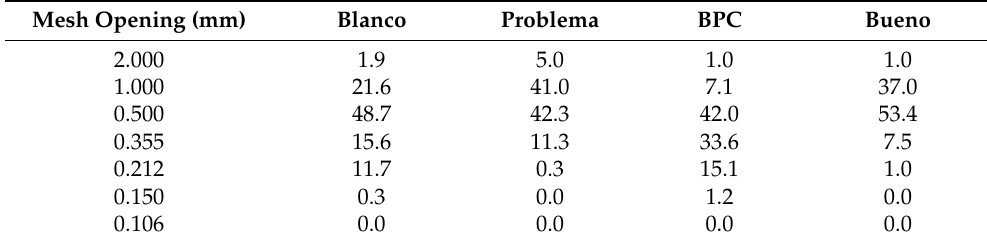
Table 2. Percentage of particles retained on each mesh.